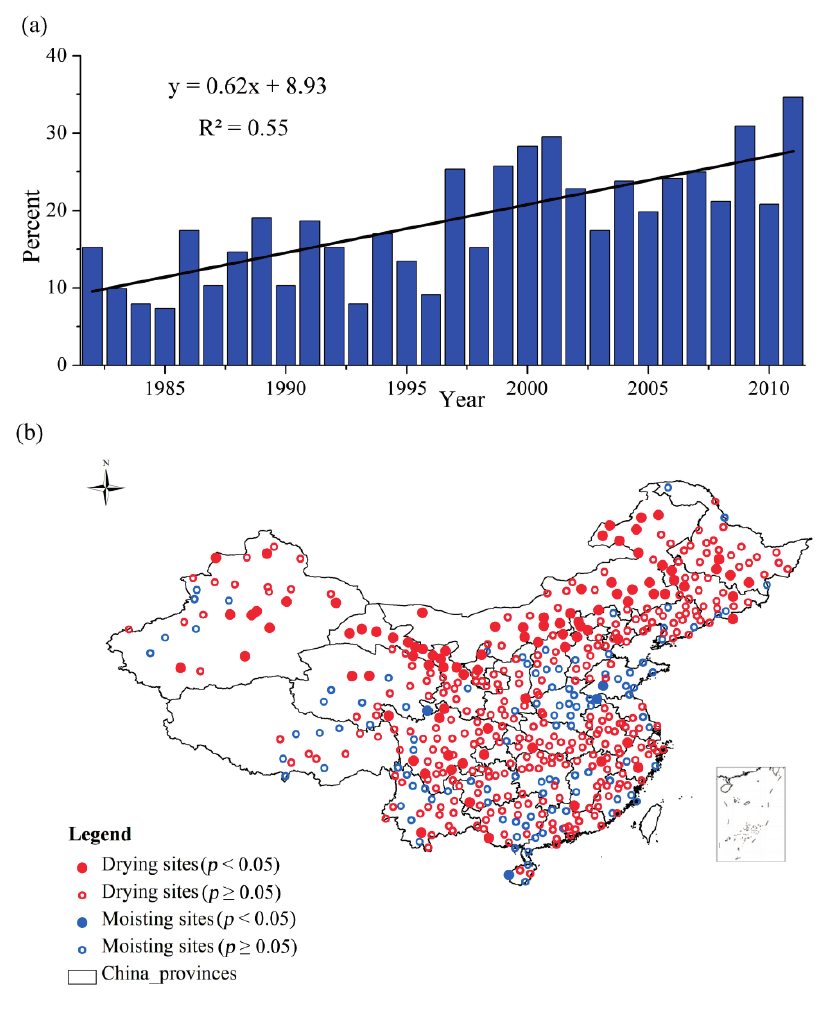
Figure 3. ( a ) The frequency of drought from 1982 to 2011 based on the SPEI opt ; ( b ) The drying trend based on the time series of SPEI opt